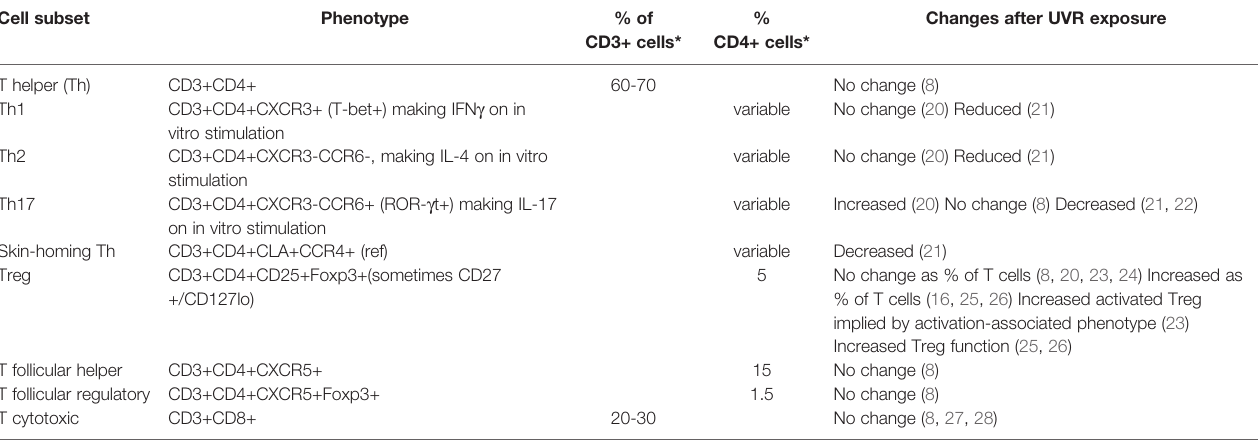
TABLE 1 | Changes to circulating T cell subsets associated with UVR exposure. T cells express CD3, the T cell co-receptor. They are then subdivided according to their phenotype that frequently re fl ects their function. Classi fi cation has often been aided by detection of intracellular cytokine expression after a short stimulation in vitro . CXCR5 allows cell migration into germinal